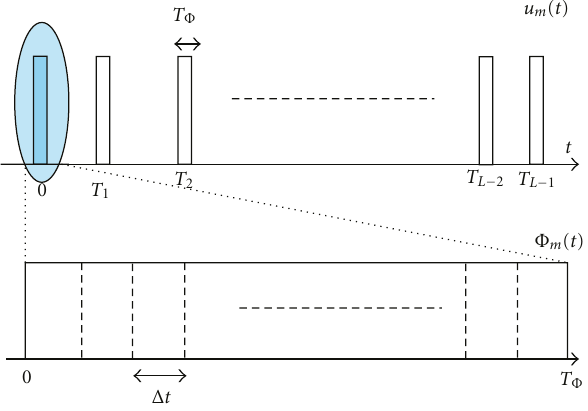
Figure 2: The structure of frequency-hopping waveforms.